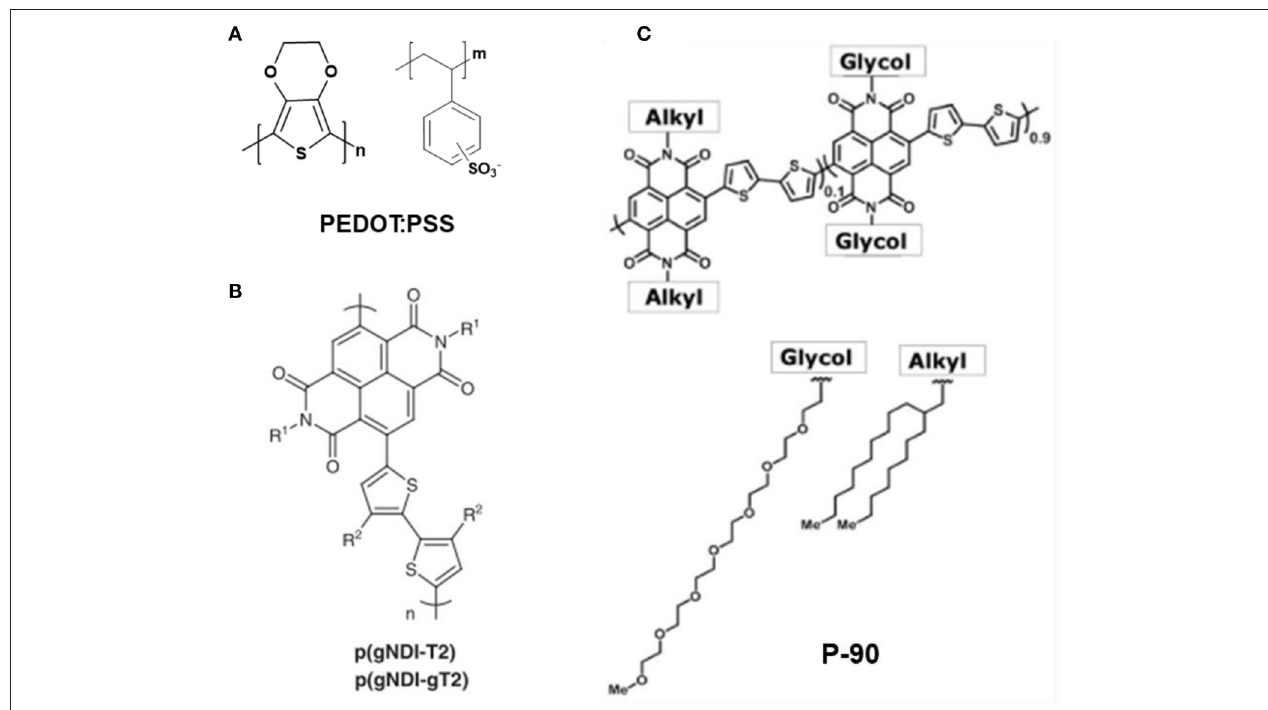
FIGURE 4 | Chemical structure of typical conducting polymer: (A) PEDOT: PSS. (B) p(gNDI-T2) and p(gNDI-gT2) (Giovannitti et al., 2016). Reproduced with permission ( Giovannitti et al., 2016). Copyright © 2016 Nature Publishing Group. (C) P-90 (Pappa et al., 2018). Reproduced with permission (Pappa et al., 2018). Copyright © 2018 American Association for the Advancement of